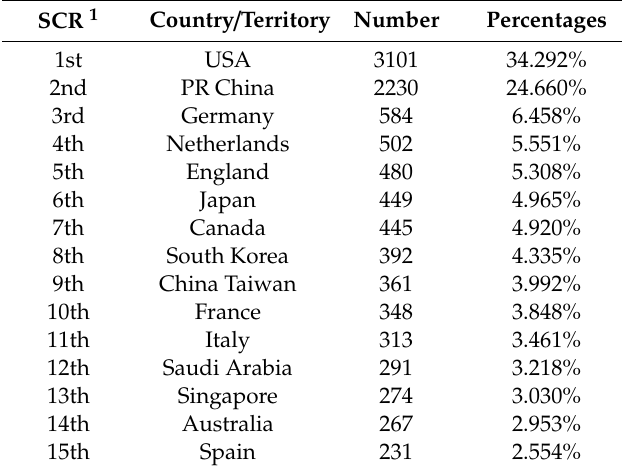
Table 1. The 15 most productive countries or territories contributed to articles on coronavirus research.